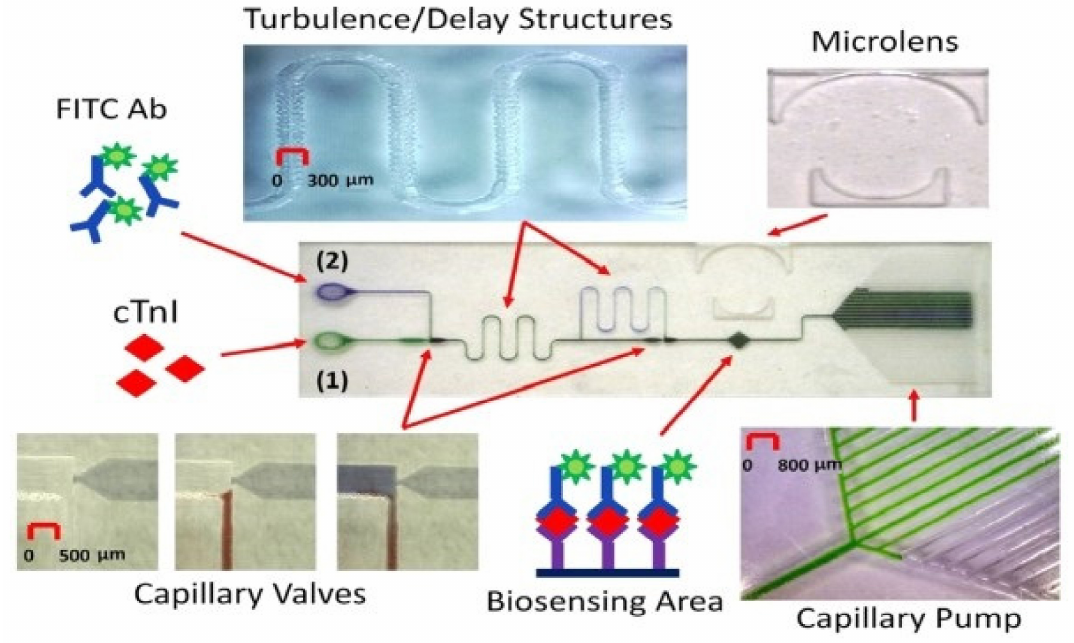
Figure 4. The microfluidic fluoroimmunoassay platform